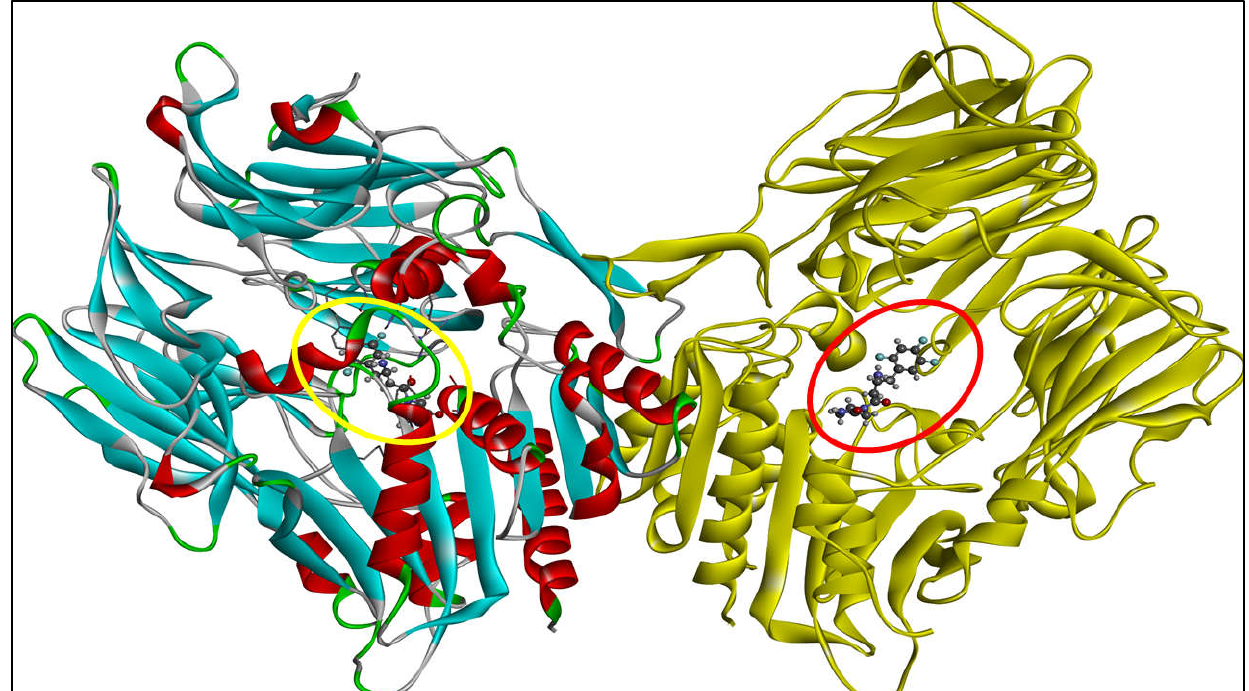
Figure 8. The 3D view of the target enzyme, Chain A displayed in red-sky blue color and Chain B exemplified in yellow color along with reference inhibitor present in the active binding pocket of both the chains denoted by yellow and red circle respectively.